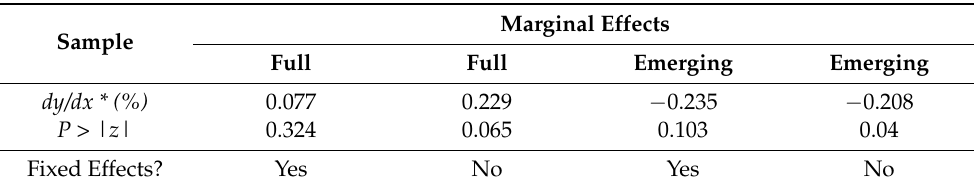
Table A2. This table shows the marginal effect of SocialMedia on Compete. The figures are derived from probit regressions run on SocialMedia with Compete as the dependent variable. Columns 1 and 2 show the results for regressions run on the full sample and columns 3 and 4 show the results from the active market sample as described in the main text.